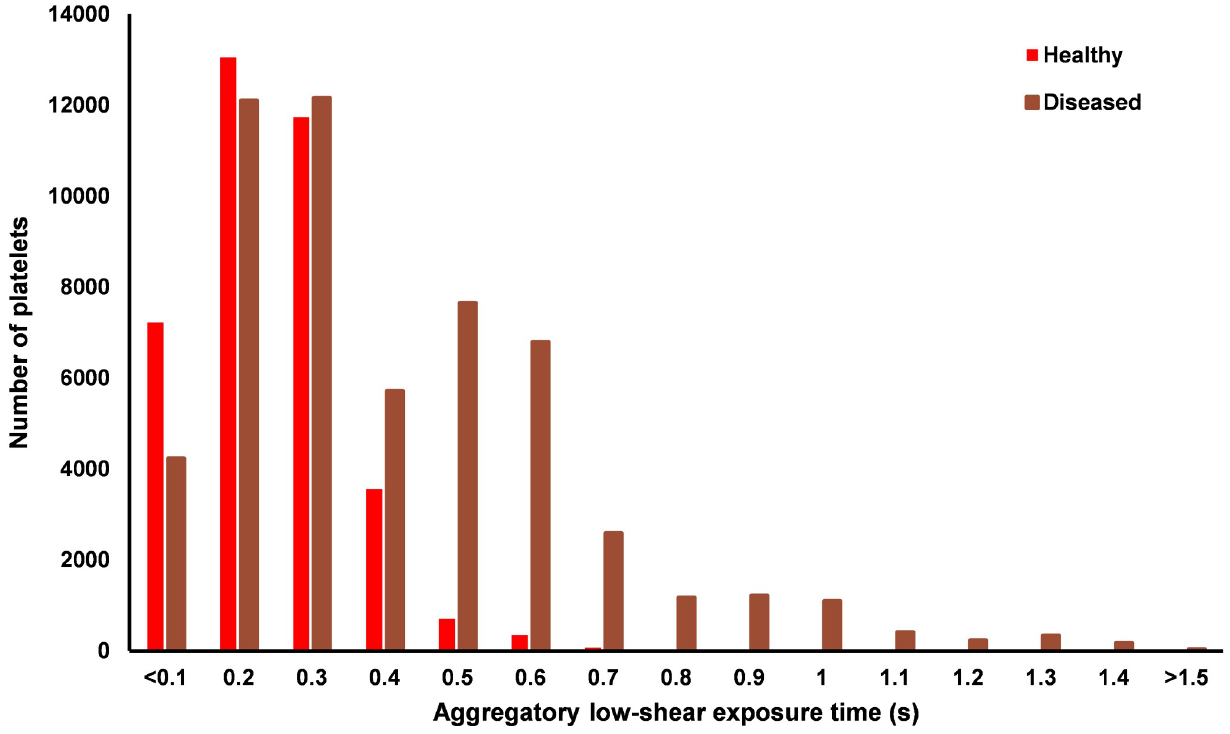
Fig 11. Bar chart showing the distribution of exposure time for the platelets which experienced a RBC shear rate < 50 s -1 .